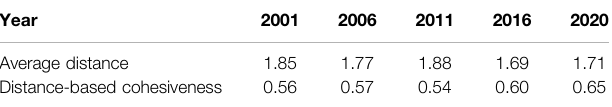
TABLE 2 | Distance and cohesiveness of the water network in the